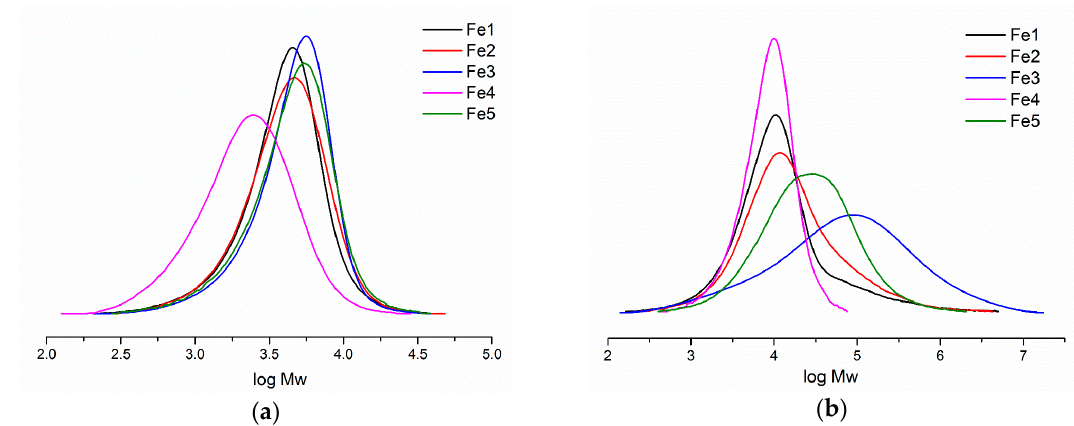
Figure 4. ( a ) GPC curves of the resultant polyethylenes by Fe1 – Fe5 /MMAO (run 6, 12-15, Table 3); ( b ) GPC curves of the resultant polyethylene by Fe1 – Fe5 /MAO various ratio of Al/Fe (run 16–20, Table 3).